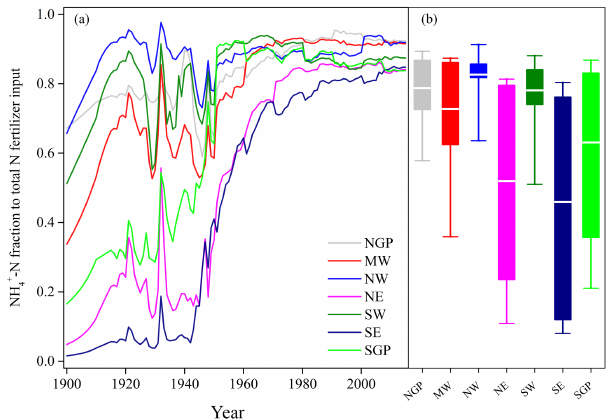
+ -N to total N use in the con- Figure 6. Regional fraction of NH 4 tiguous US during 1900–2015. (a) Historical change of NH + -N 4 fraction across the seven regions. (b) Boxes include 25–75% of re- gional fractions during 1900–2015, white lines are mean values, and whiskers comprise the whole range of data. The seven regions are the Northern Great Plains (NGP), the Midwest (MW), the North- west (NW), the Northeast (NE), the Southwest (SW), the Southeast (SE), and the Southern Great Plains (SGP).